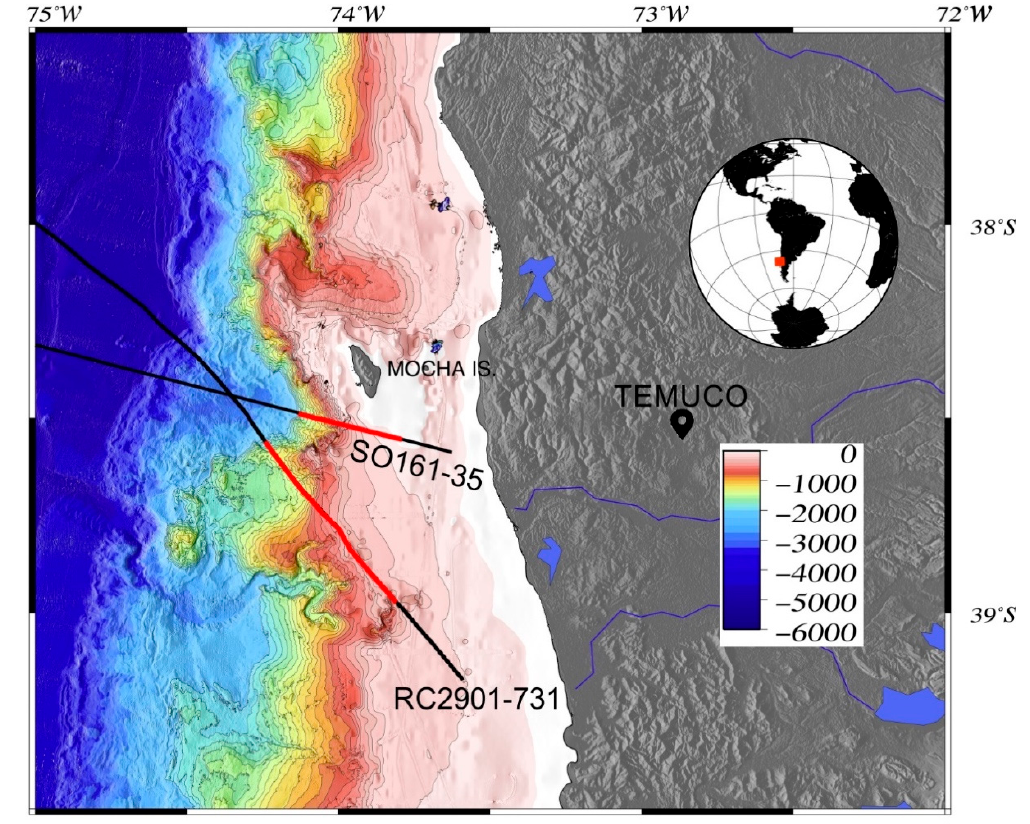
Figure 1. Location map. Red lines indicate the parts of the seismic sections analysed in this study.